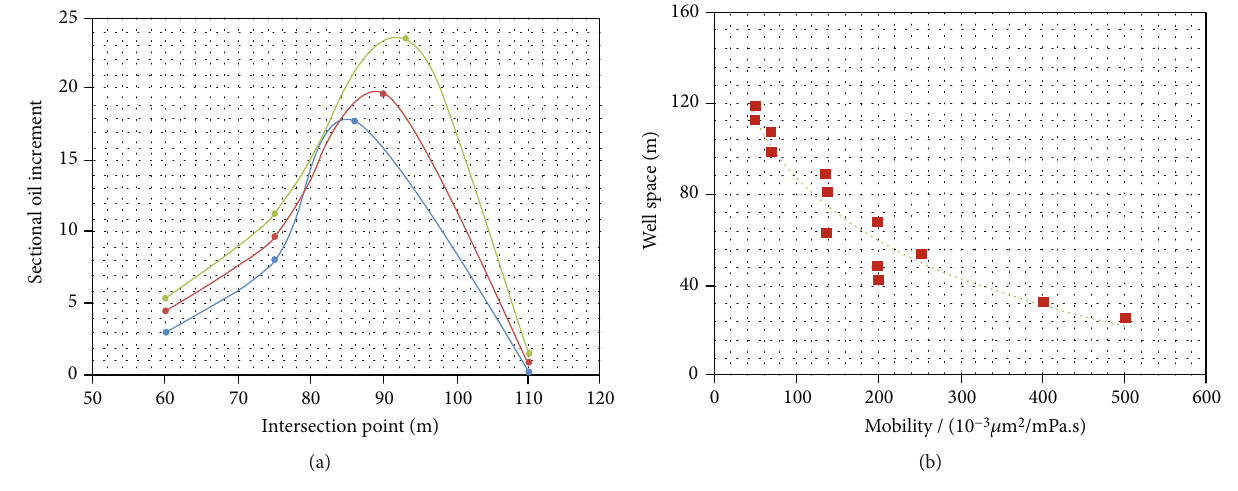
Figure 12: Relationship between well space and